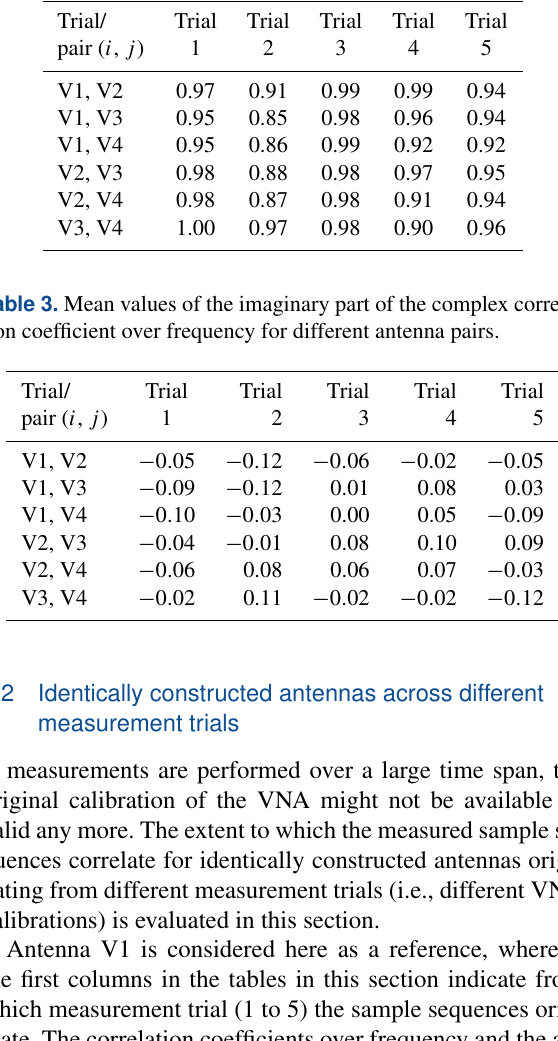
Table 2. Mean values of the real part of the complex correlation coefficient over frequency for different antenna pairs.